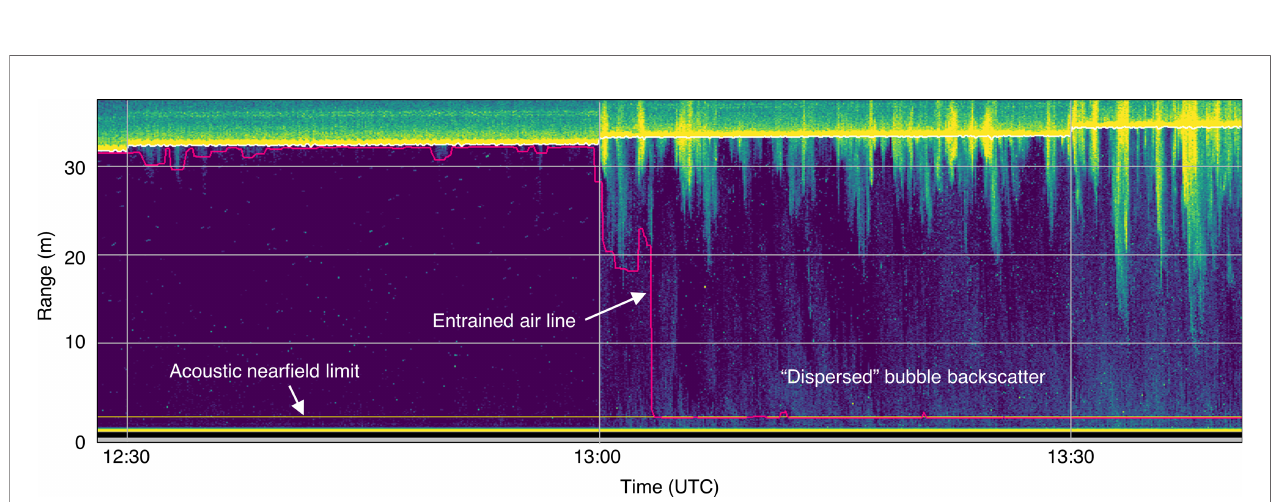
FIGURE 4 | Subset of echogram shown in (Figure 3) , showing backscatter from fi sh and entrained air (delineated by pink line). (A) Small fi sh aggregations clearly visible in upper water column, separate from entrained air layer. (B) Aggregations appear to shift upward into entrained air layer, where they can still be seen. (C) Unclear whether backscatter is from fi sh aggregations or detached/dispersed bubble plumes.